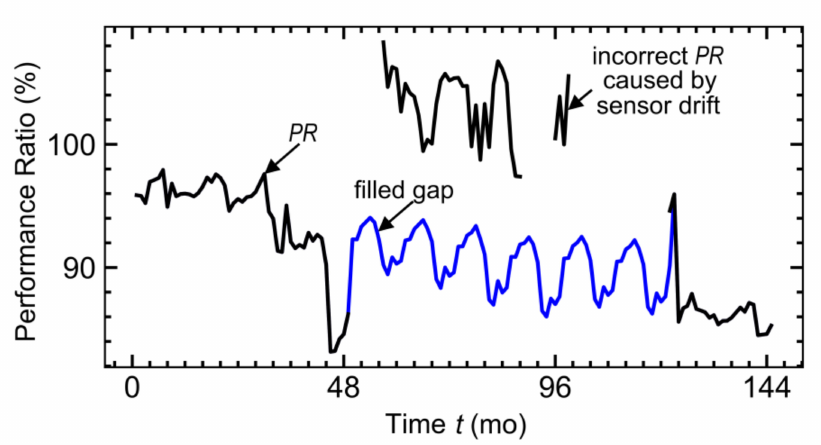
Figure 7. Monthly PR time series of the sw165St multi-c-Si PV system in Stuttgart, Germany calculated with the measured data in black and imputed using the time series reconstruction algorithm in